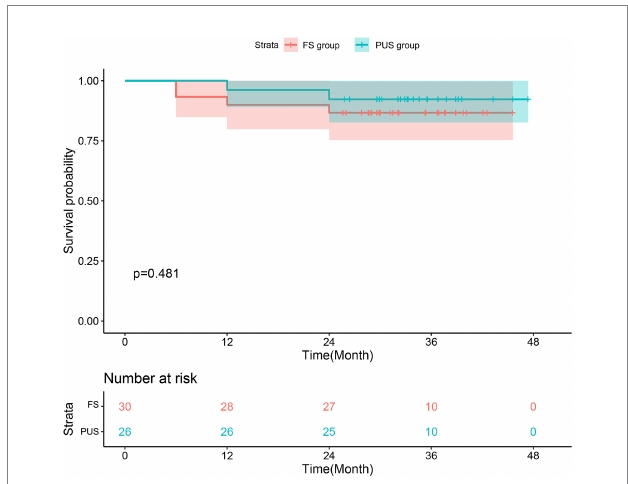
FIGURE 8 Kaplan–Meier estimates of survival for patients with acute type A aortic dissection who underwent total arch repair with triple-branched stent